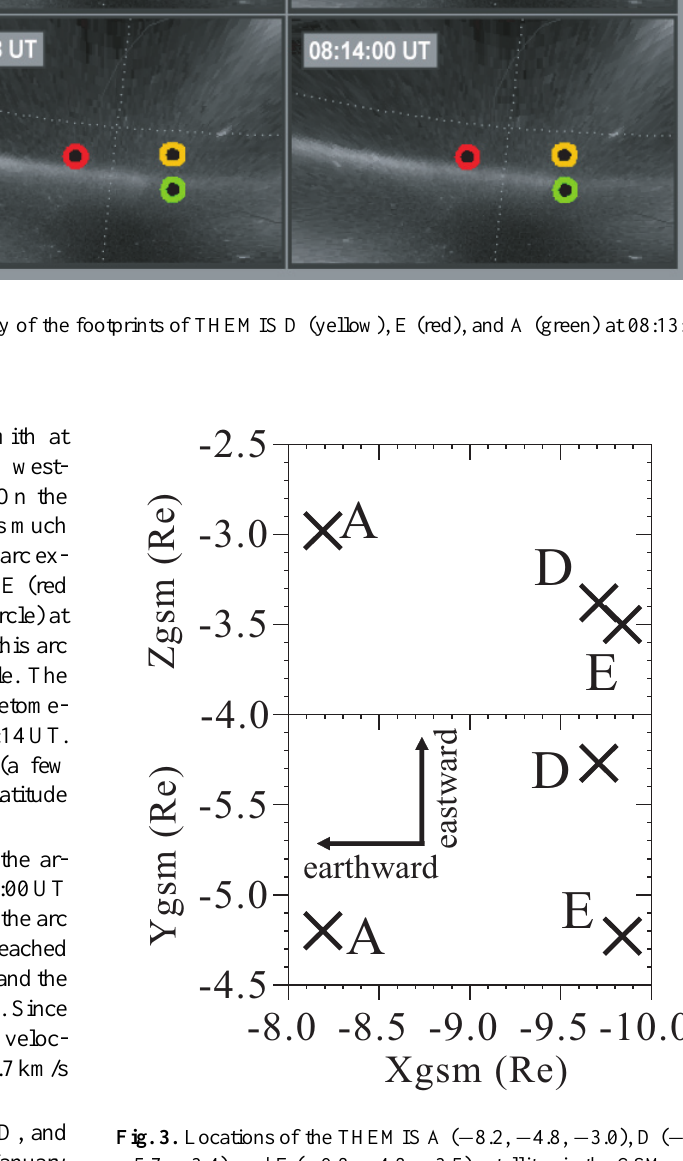
THEMIS A/D in Figs. 1 and 2 maps to the eastward (mi- nus Y GSM ) and earthward (plus X GSM ) propagation of some corresponding structure in the magnetosphere in the bottom panel of Fig.